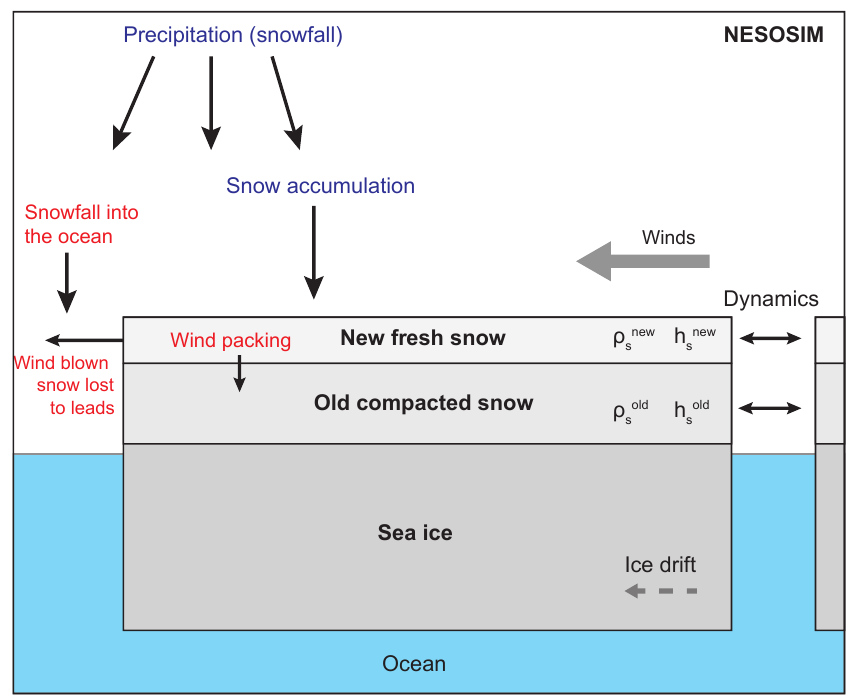
Figure 1. Schematic of the NASA Eulerian Snow On Sea Ice Model (NESOSIM) v1.0 presented in this study. The red (blue) text indicates processes that result in a loss (gain) of snow. “Dynamics” indicates the combination of ice–snow advection and convergence–divergence which can cause either loss or gain of